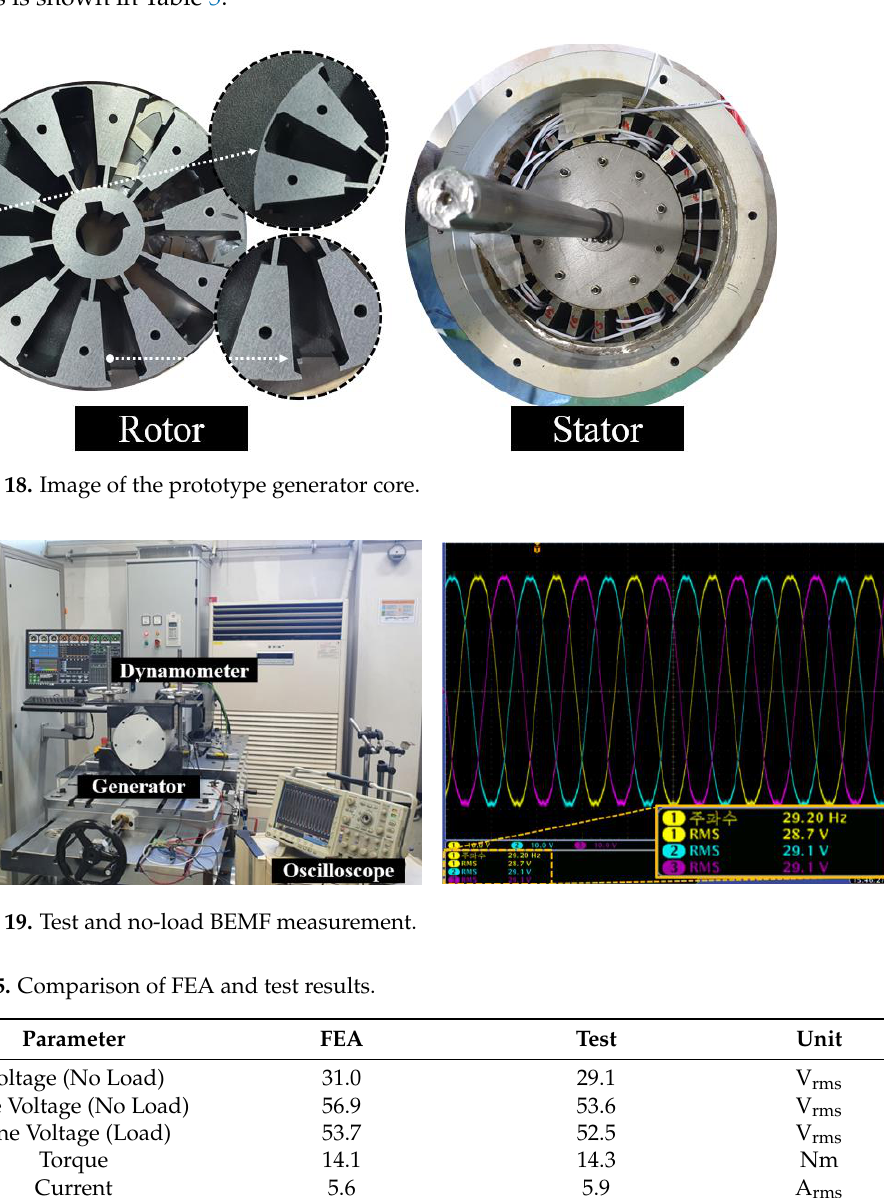
Table 5. Comparison of FEA and test results.